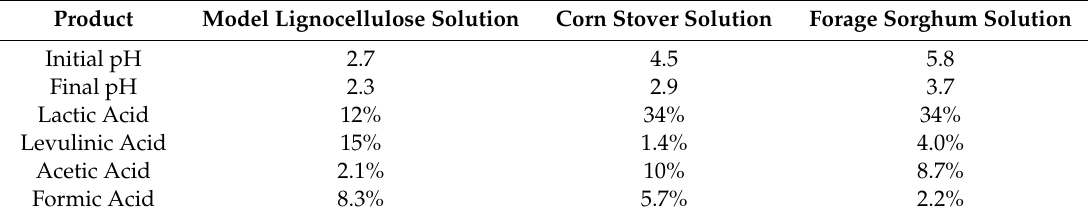
Table 2. Comparison of yields between model sugar solutions and actual sugar solutions extracted Figure 200 °C, 5 h reaction time, and a 2:1 catalyst to sugars ratio.